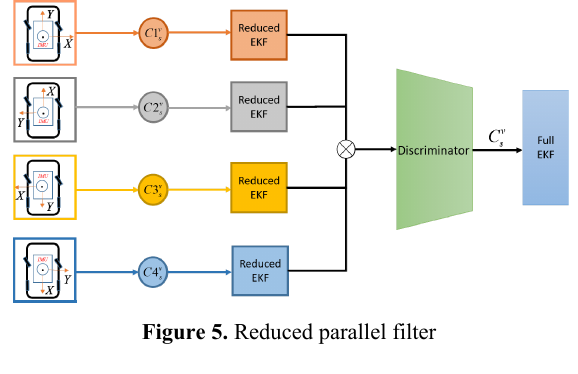
Figure 5. Reduced parallel